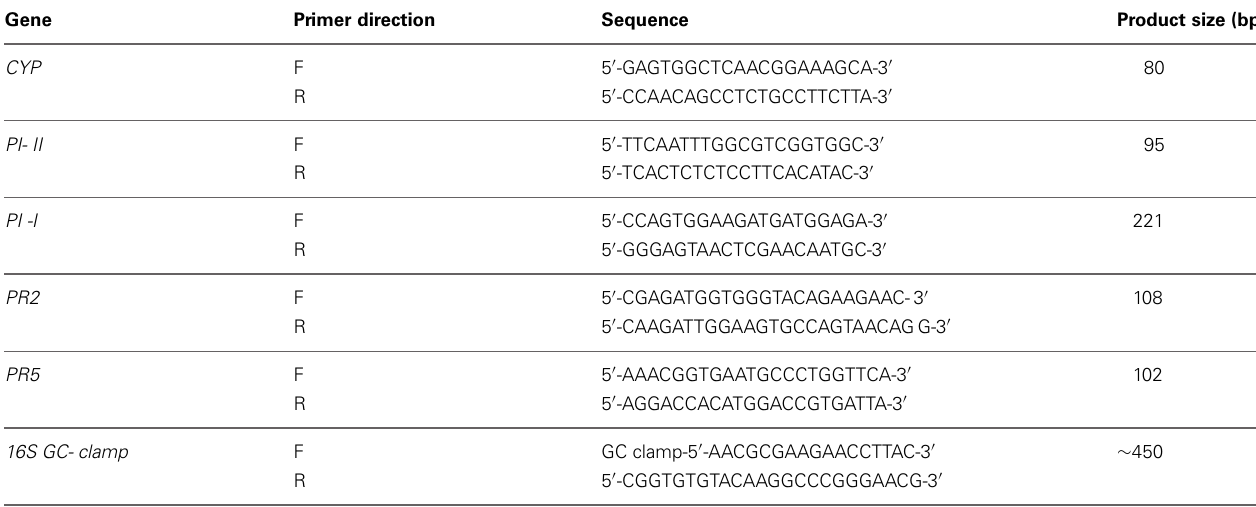
Table A1 | Quantitative real-time PCR (qRT-PCR) and denaturing gradient gel electrophoresis (DDGE) list of forward (F) and reverse (R) primers and PCR product sizes.